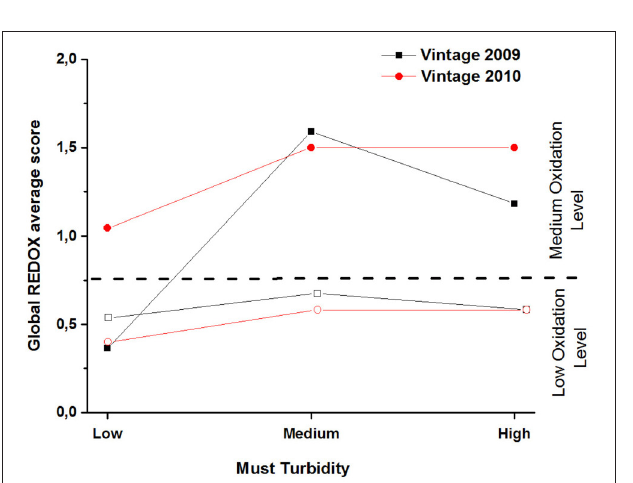
FIGURE 3 | REDOX sensory scores of dry white wines, tasted globally (nose and palate), from vintage 2009 (black) and 2010 (red), plotted against the level of must turbidity and for the two types of bottle closures: synthetic coextruded stopper (filled square and circle symbols) and screw cap (open square and circle symbols).